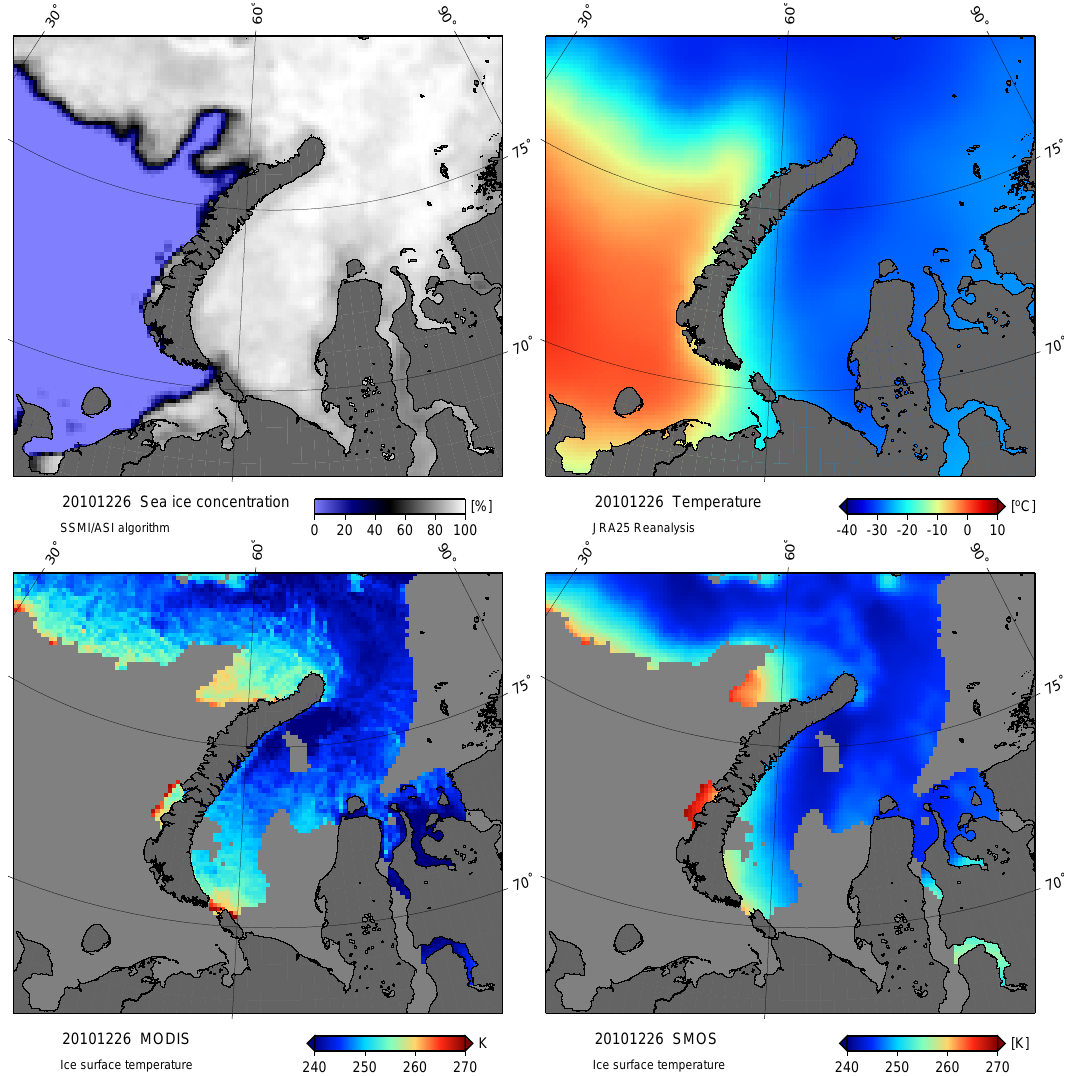
Figure 17. SSM/I ice concentration (upper left), JRA-25 surface air temperature (upper right), MODIS- and SMOS-based snow/ice surface temperature (lower left and lower right) in the Kara Sea on 26 December 2010. 56